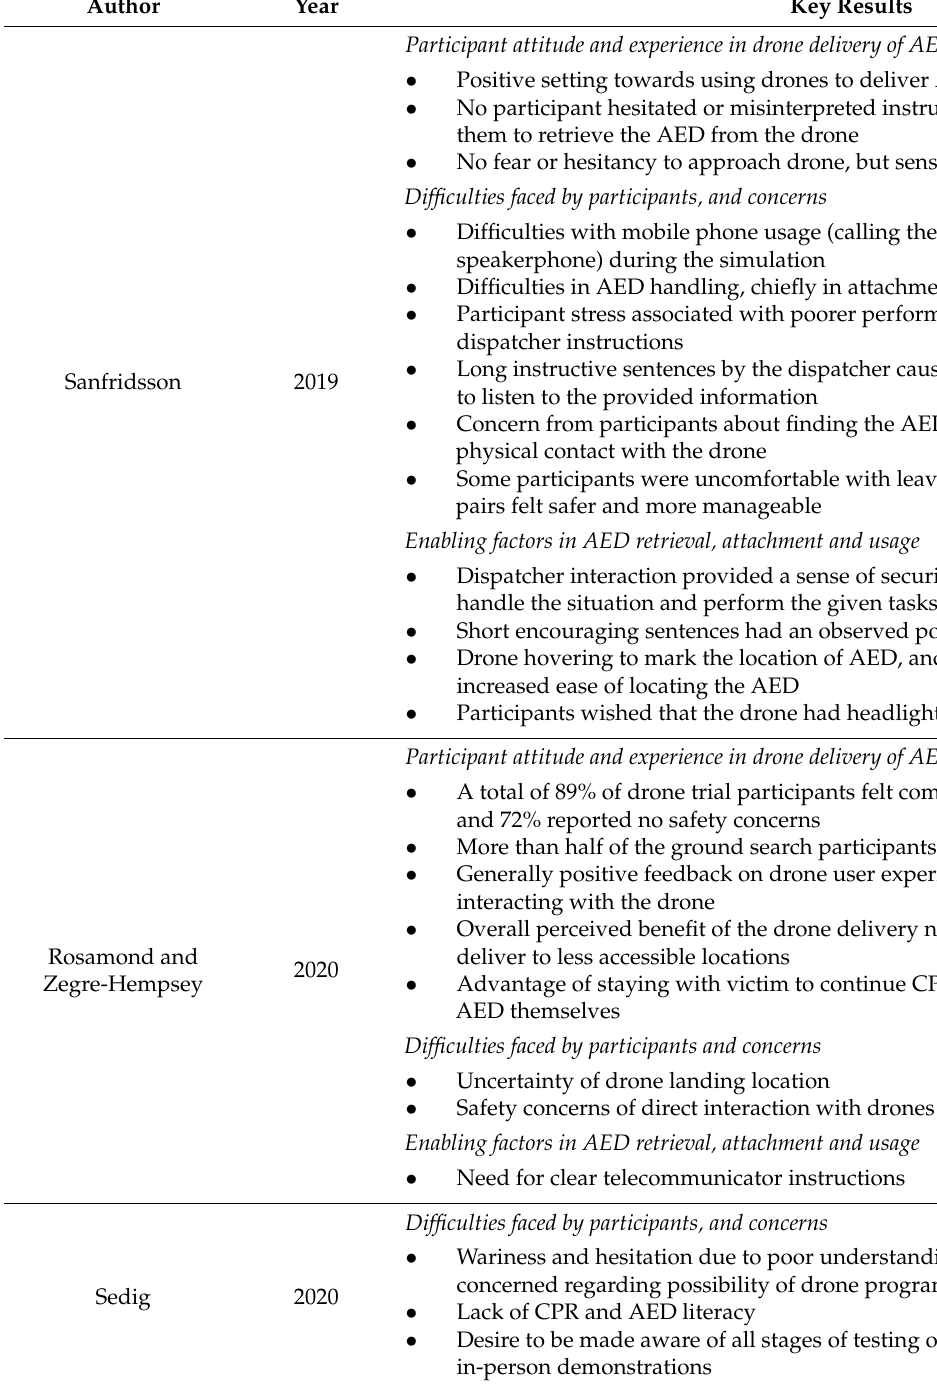
Table 3. Summary of Qualitative